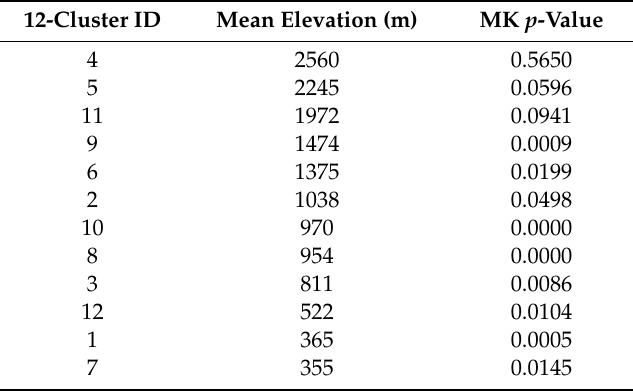
Table 4. Characteristics of the 12 clusters produced by agglomerative hierarchical clustering analysis and MK trend statistics of the averaged within-cluster grid point values of the seasonal (NDJFMA) snow depth HS (see Figure 9). The direction of all trends/tendencies is downward.